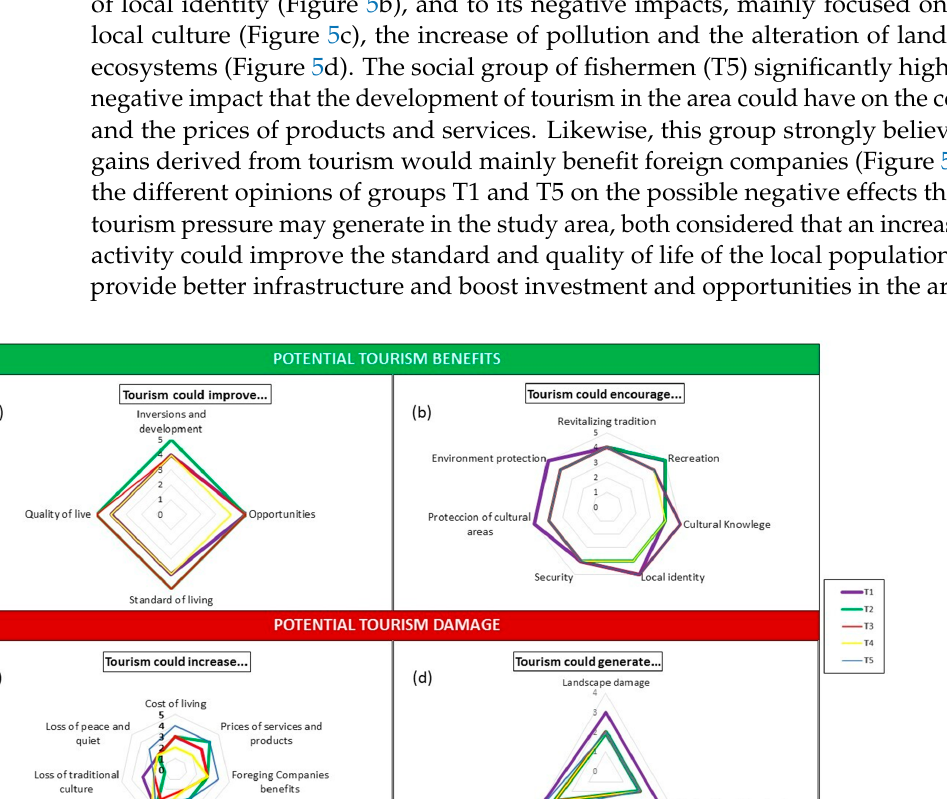
9 of 19 Figure 4. Dendrogram of the hierarchical cluster analysis calculated from the first 7 axes of the MCA. The five groups of social actors are differentiated, and their main discriminant variables are indicated. 3.4. Tourism Impact Perception on the Territory The analysis of the results (Appendix B Table A2) highlighted the existence of evident discrepancies between social groups regarding their opinion on the possible positive and